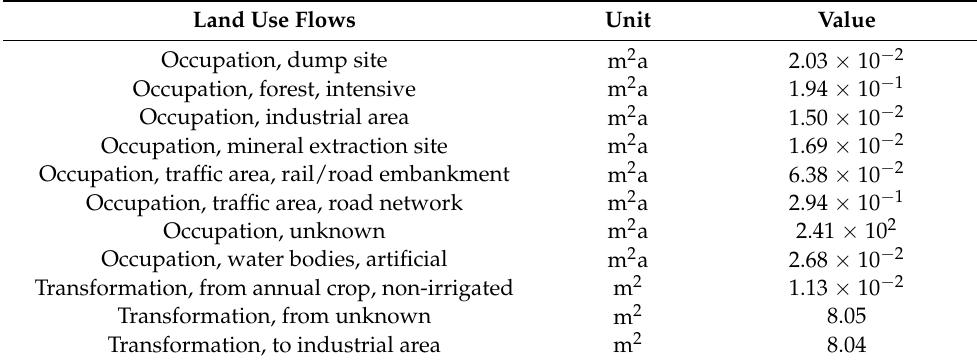
Table 4. Life-cycle land occupation and transformation of PV in Vietnam. Land Use